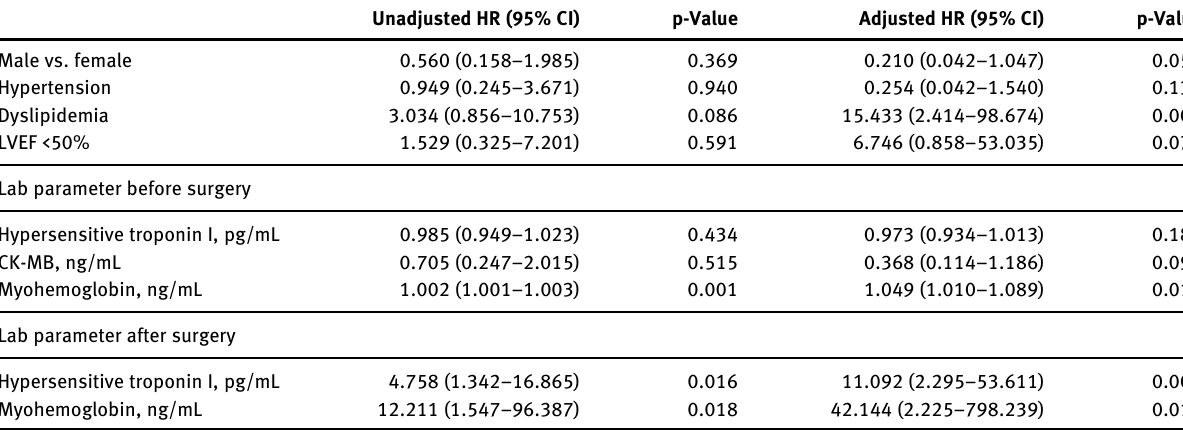
Unadjusted HR (  % CI) p-Value Adjusted HR (  % CI) p-Value